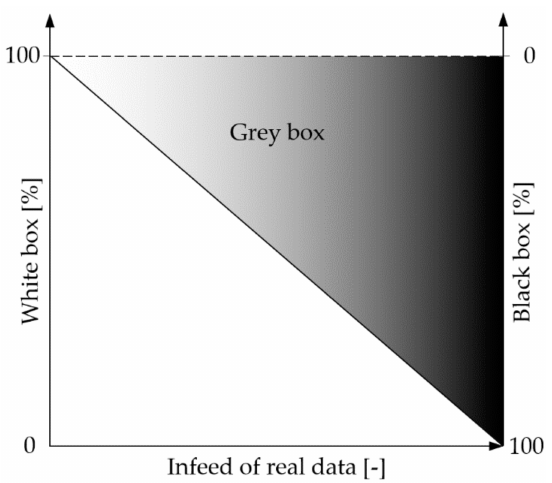
Figure 10. Change of model characteristics with increase of infeed data: the original FEA and real-physics-based model is overruled with more data from practical